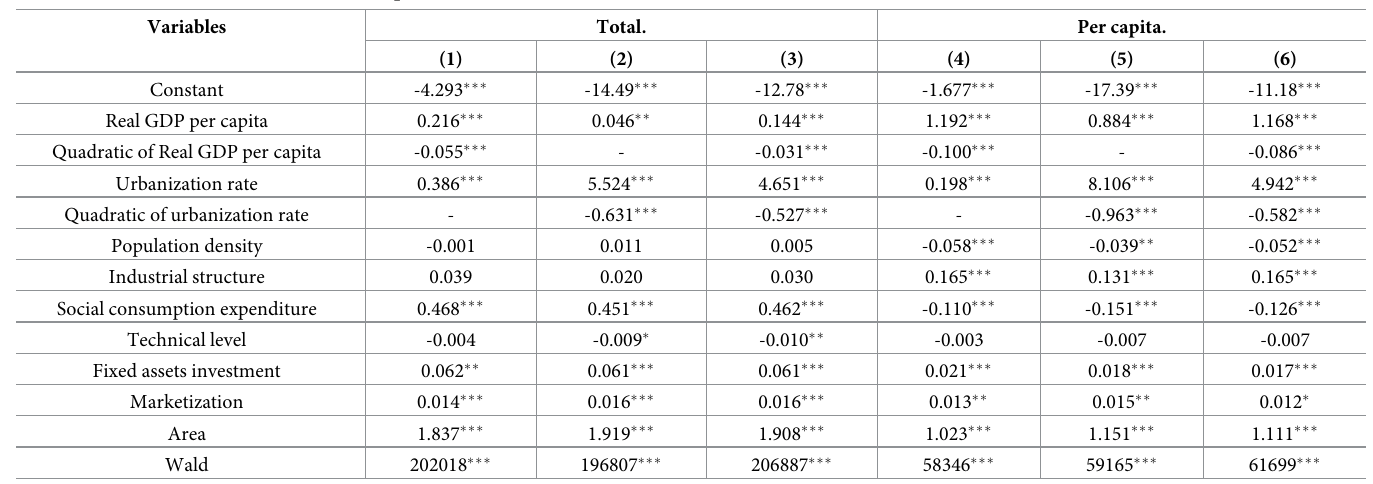
Table 3. FGLS estimation results of the static panel data model.